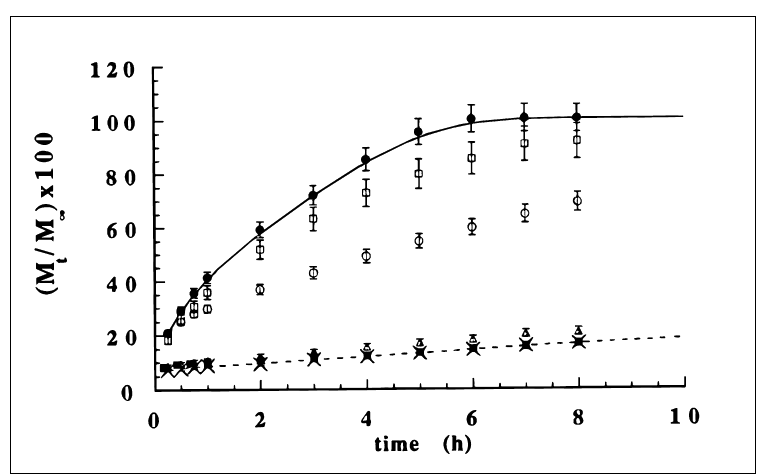
Figure 9. Effect of Ca on the release profiles of TPH in phosphate buffer (pH=7.4). r